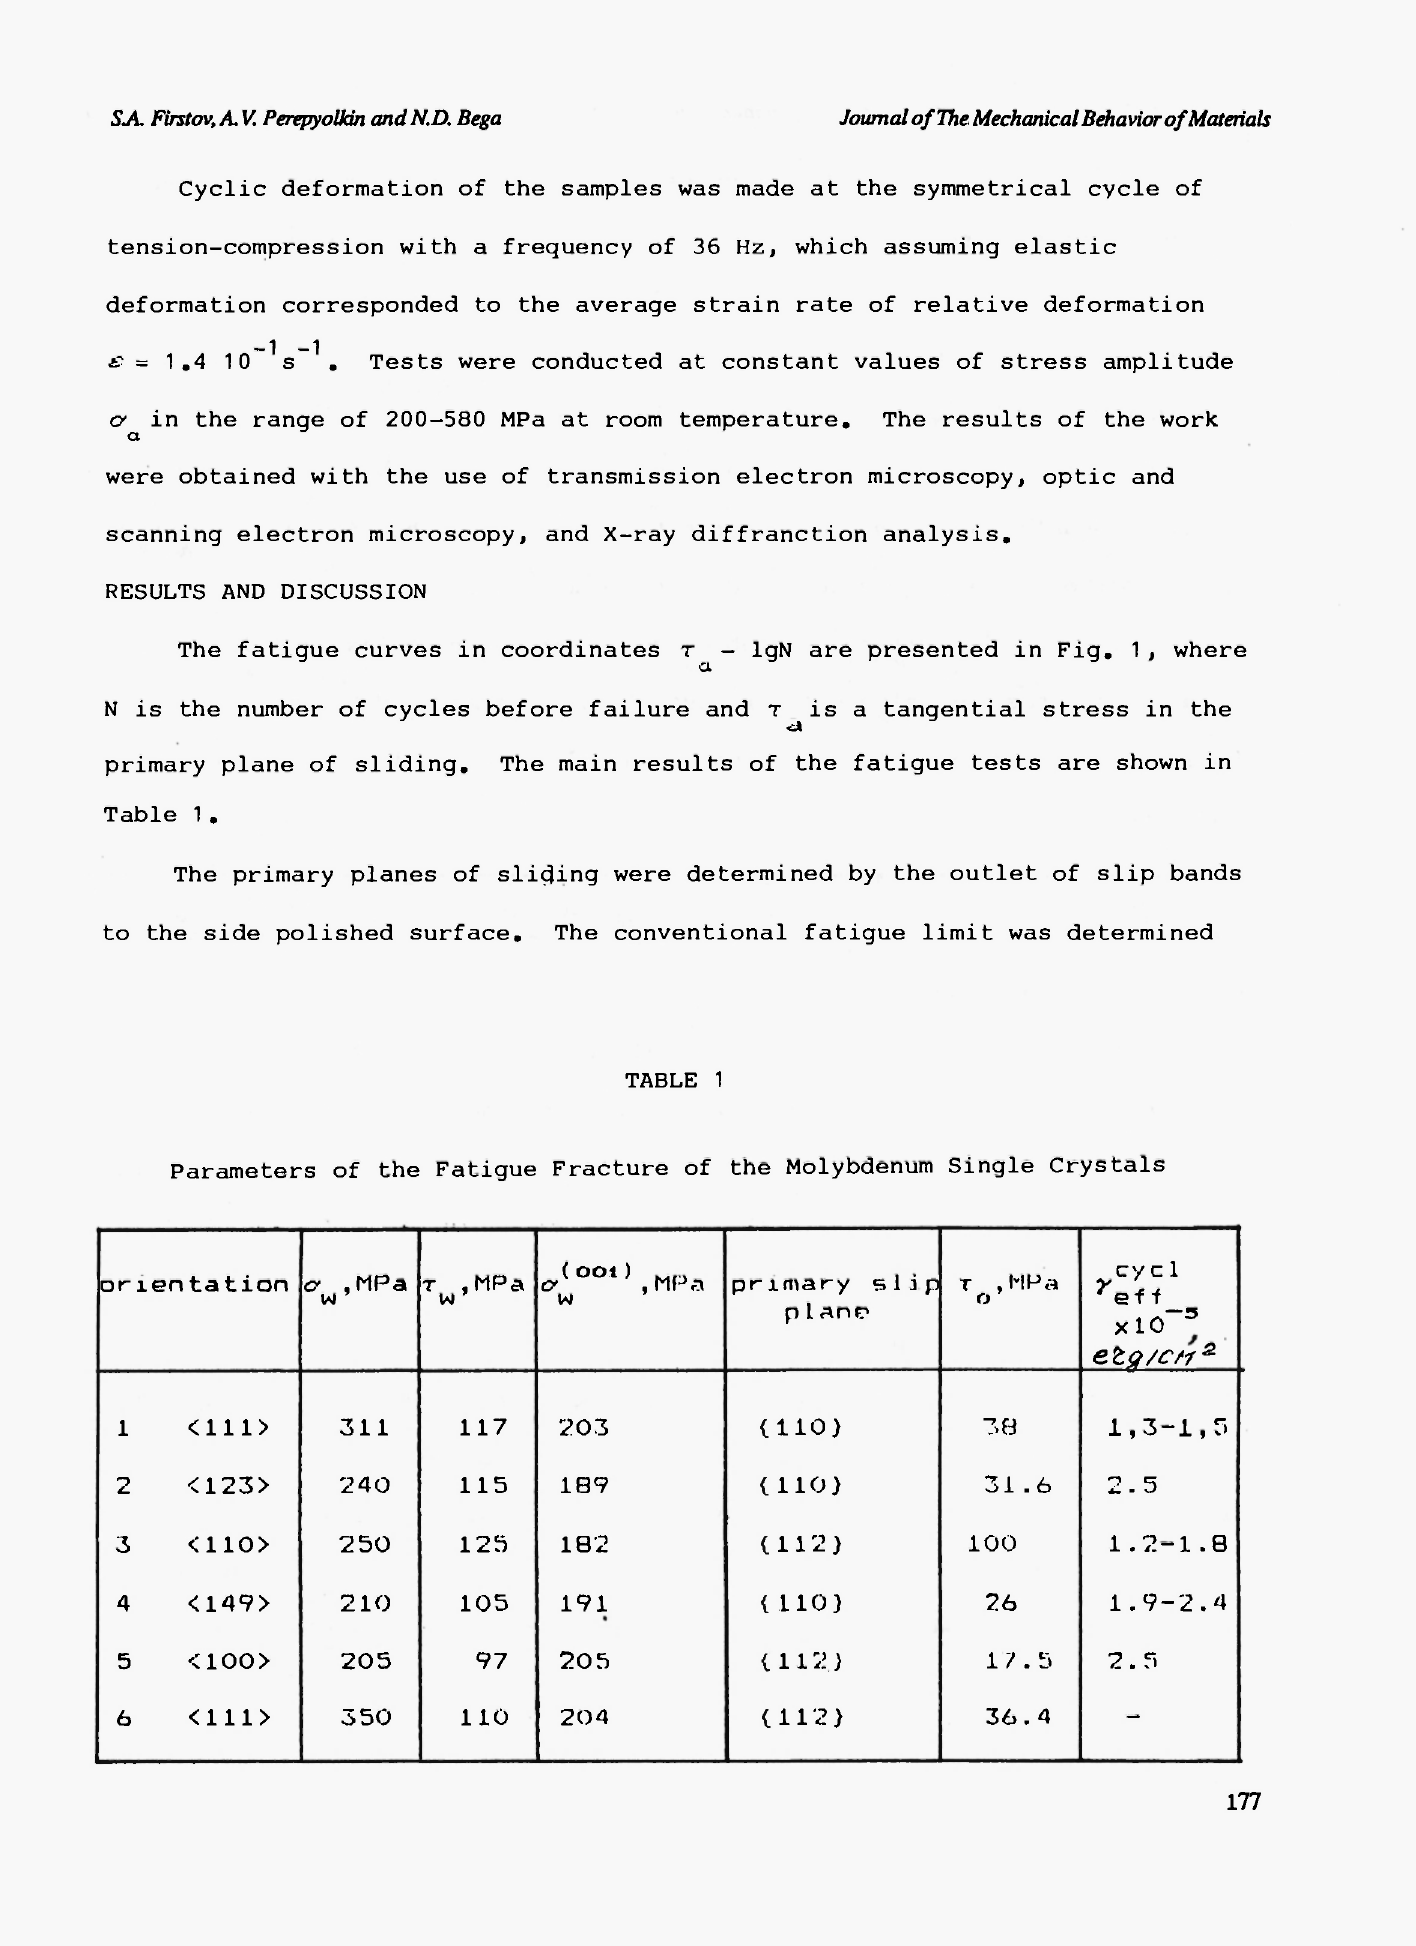
Parameters of the Fatigue Fracture of the Molybdenum Single